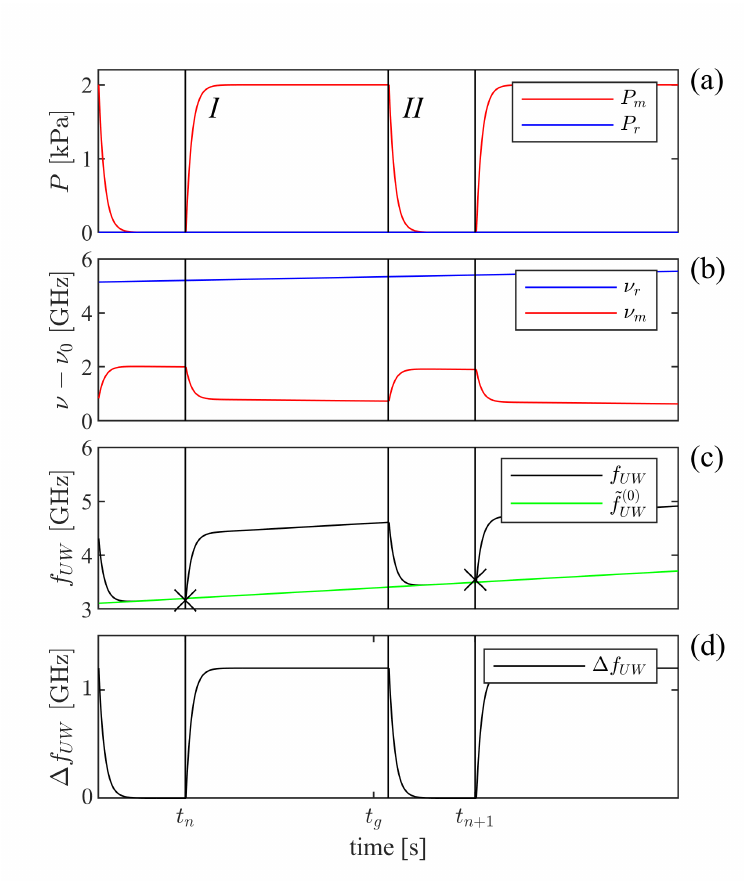
Figure 4. A schematic illustration of the principles of GAMOR implemented on a system exposed to campaign-persistent drifts. Panel ( a ) shows, as functions of time, by the the upper red curve, P m ( t ) , the pressure in the measurement cavity, and by the lower blue curve, the pressure in the reference cavity, P r ( t ) . Panel ( b ) depicts the corresponding frequencies of the measurement and reference lasers, ν m ( t ) (the lower red curve) and ν r ( t ) (the upper blue curve), respectively, for display purposes, both offset by a common frequency. Panel ( c ) displays, by the upper black curve, the corresponding unwrapped beat frequency in the presence of gas, f UW ( t ) , and the lower green line depicts the ( 0 ) ( t n , t , t ) . Panel ( d ) displays the estimated evacuated measurement cavity beat frequency, ˜ f n + 1 UW drift-corrected shift in unwrapped beat frequency, ∆ f UW ( t ) . While the data that are used in ordinary GAMOR constitute the data points in the last part (10–20%) of section I (the time period between t n and slightly after t g ) in panel ( d ), which are averaged to a single data value, in this work where cycle resolved assessments are performed, a significant part (ca. 80%) of the data in section I is used in an unaveraged manner. Note that the drifts have been greatly exaggerated for